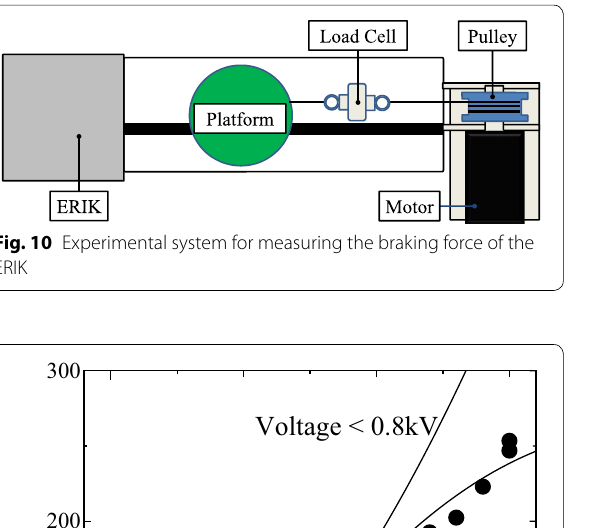
Fig. 12 Reference and measured force relation of the prototype